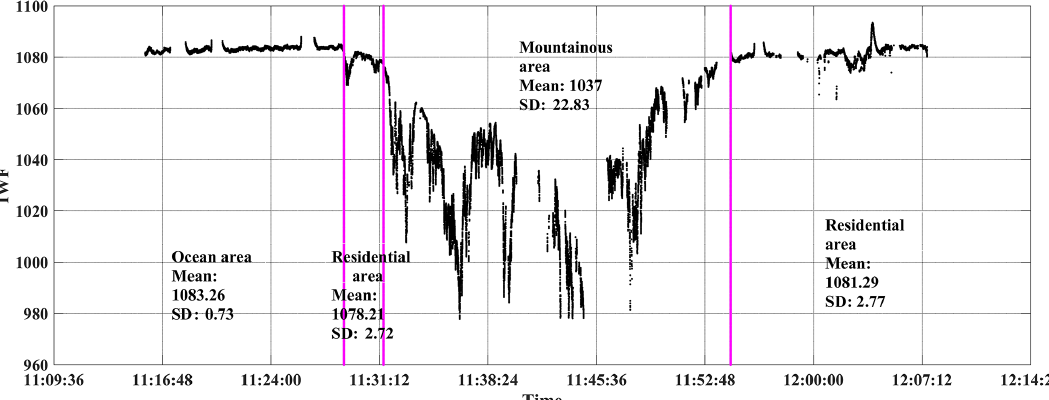
Figure 11. IWF results over ocean, urban residential, and mountainous areas on 14 March 2019. The purplish red vertical line represents the boundary of different surface